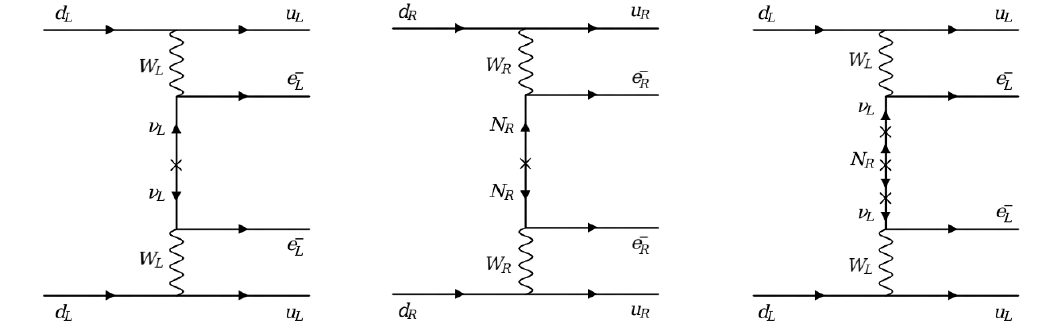
Figure 1 . 0 (cid:23) 2 (cid:12) diagrams leading to the standard contribution, its right counterpart, and the light-heavy neutrino mixing contribution, respectively.